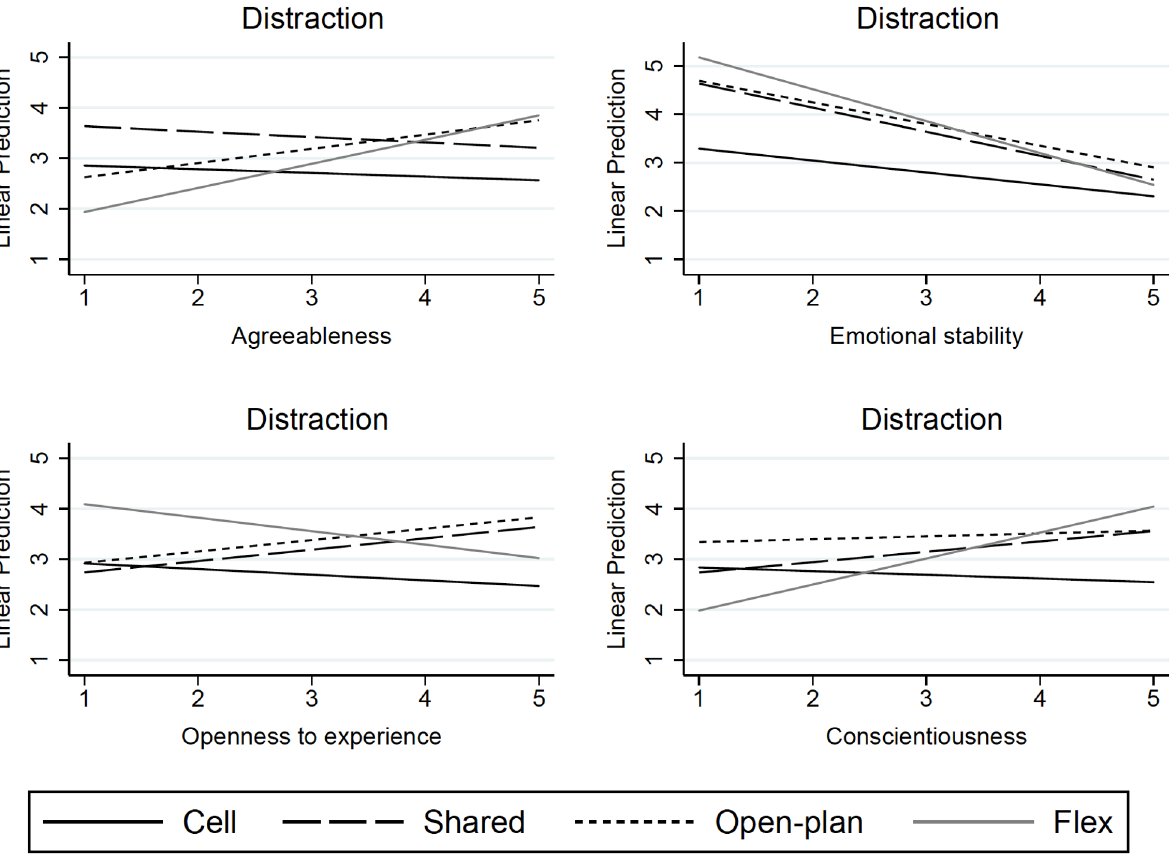
Fig 1. Adjusted predictions of office type upon distraction in relation to selected personality traits in 1205 Swedish public and private sector